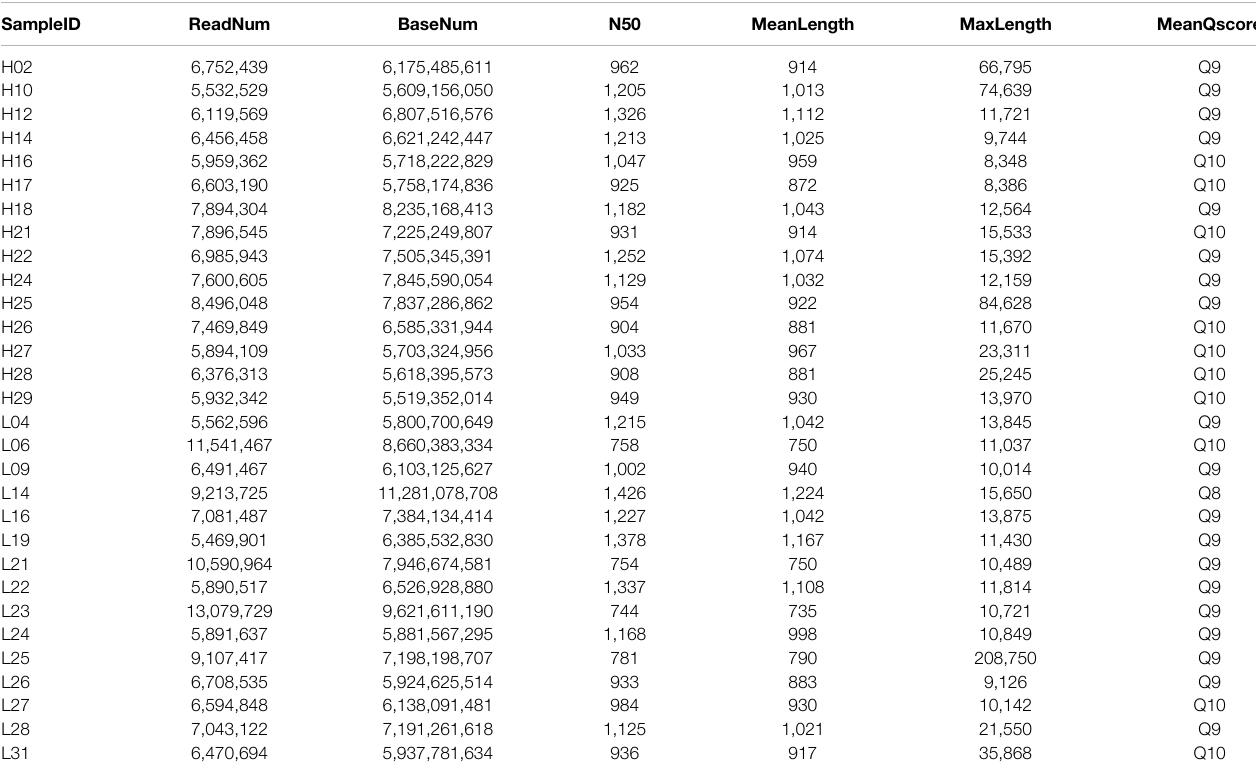
TABLE 2 | Clean reads generated by Nanopore sequencing.